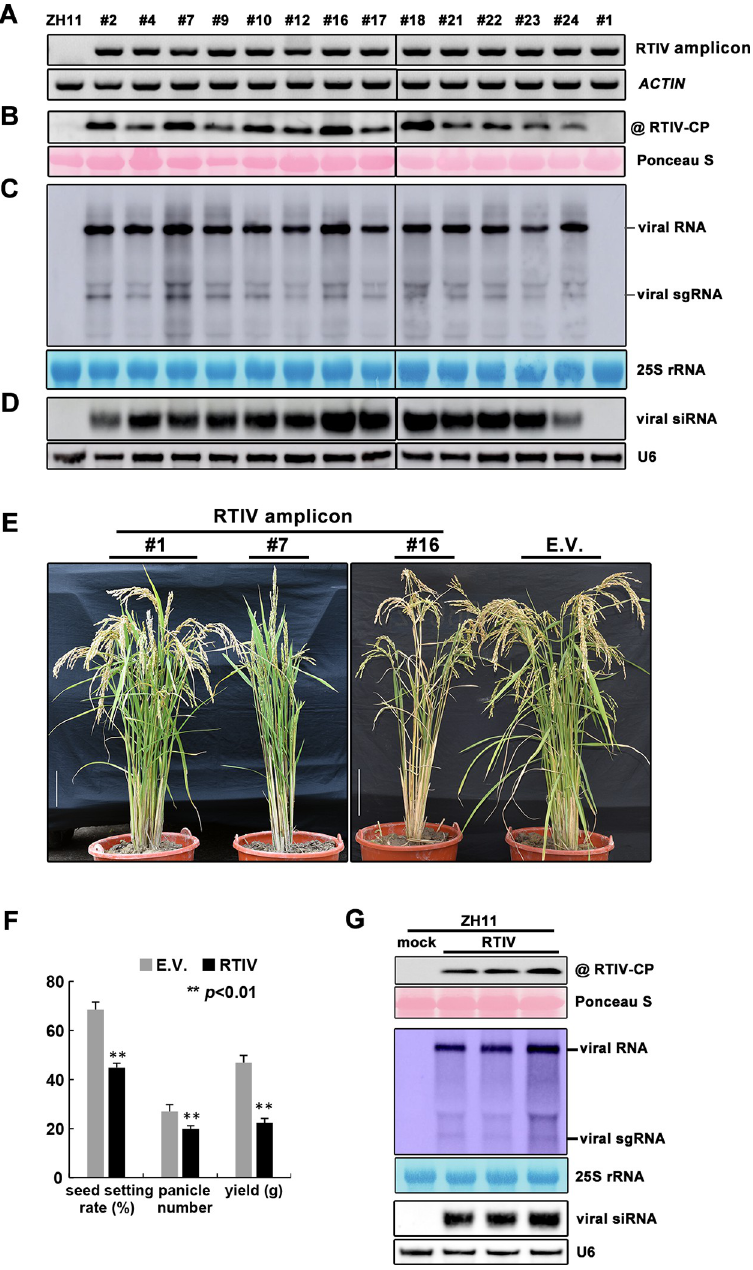
Fig 4. RTIV replication and pathogenesis in rice cultivar induced by RTIV encoded in a stably integrated transgene. (A) PCR detection of the RTIV transgene in transgenic Zhonghua-11 plants. (b-d) Detection of RTIV CP by Western blotting. (B) RTIV genomic/subgenomic (sg) RNAs (C) and RTIV siRNAs (D) by Northern blotting in independent lines of Zhonghua-11 rice plants carrying a stable virus transgene. Loading control was monitored by ponceau staining, 25S rRNA staining or U6 RNA probing in the same membrane. (E) Phenotypes of transgenic Zhonghua-11 plants carrying an empty vector transgene (E.V.), a non-replicating (#1) or replication-competent (#7 and #16) RTIV transgene. Scale bars = 10 cm. (F) The seeds set rate, panicle number and individual plant yield of E.V. and RTIV replication-competent transgenic rice. ** p < 0.01 determined using the Student’s test and mean significant difference. Error bar: standard deviations. (G) Detection of RTIV CP, genomic/subgenomic (sg) RNAs and vsiRNAs by Western blotting or Northern blotting in healthy Zhonghua-11 rice plants 2 weeks after RTIV transmission from above RTIV-positive transgenic rice plants, loading control was monitored by ponceau staining, 25S rRNA staining or U6 RNA probing in the same membrane.